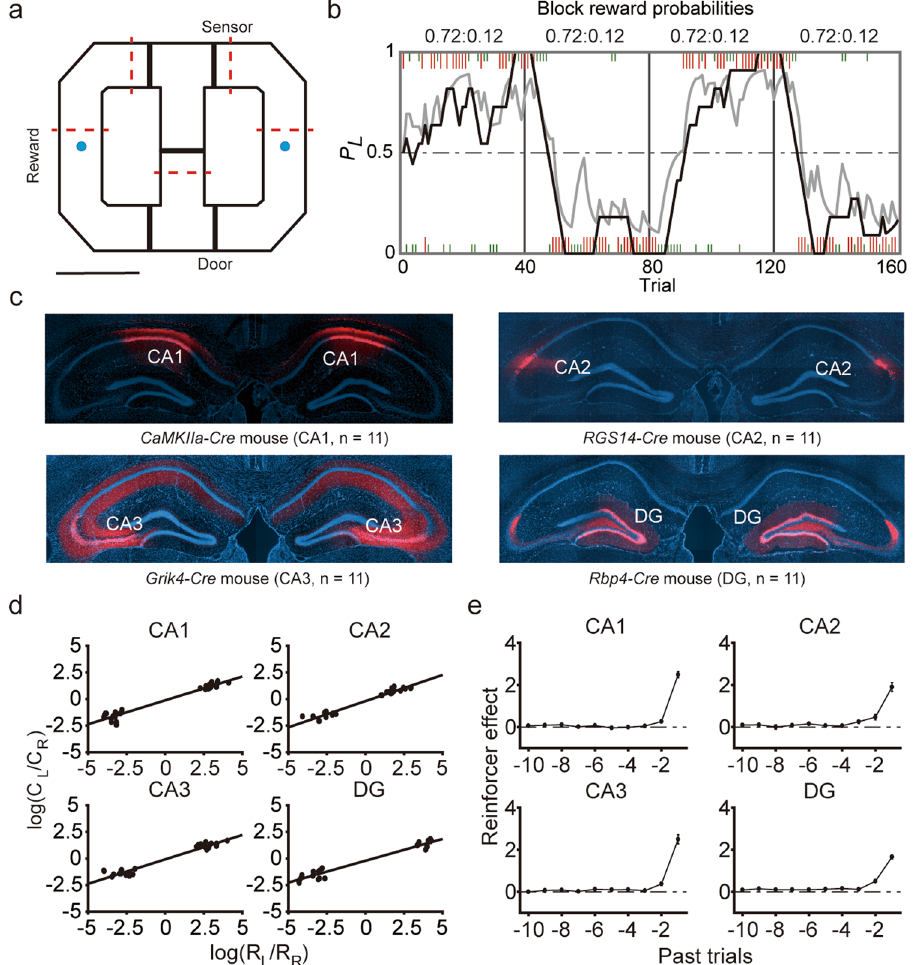
Figure 1. Behavioral performance. ( a ) The modified T-maze used for mice. The mice were allowed to choose freely between two targets (blue circles) that delivered water reward in a probabilistic manner. Thick black solid and red dashed lines denote locations of sliding doors and photobeam sensors, respectively. Calibration bar, 10 cm. ( b ) The choice behavior of a mouse during one example session. The probability of choosing the left target ( P L ) is plotted in moving average of 10 trials (gray curve). The black curve represents choice probability predicted by an RL model. Tick marks denote trial-by-trial choices of the mouse (upper, left choice; lower, right choice; red tick, rewarded trial; green tick, unrewarded trial). Each session consisted of four blocks of trials with different combinations of reward probabilities. Vertical lines denote block transitions and numbers on top indicate reward probabilities used in this example session. ( c ) Example brain sections stained with DAPI (blue) showing DIO-hM4Di-mCherry expression. ( d ) The relationship between log choice ratio (ordinate) and log reinforcement ratio (abscissa) under DMSO (control) condition is shown for each animal group. Each data point was obtained by analyzing steady-state behavioral data during one block of trials. ( e ) Average regression coefficients (mean ± SEM across animals) from a logistic regression model showing the effects of past rewards on the animal’s current choice under DMSO condition. Positive coefficients indicate the animal’s tendency to make the same choice that was rewarded in recent